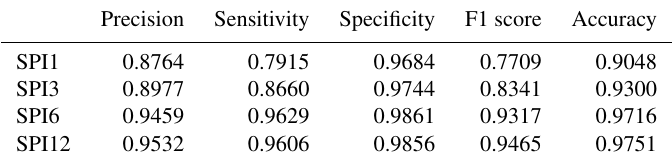
Table B2. SVM metrics median value of the top 5% configuration according to F1